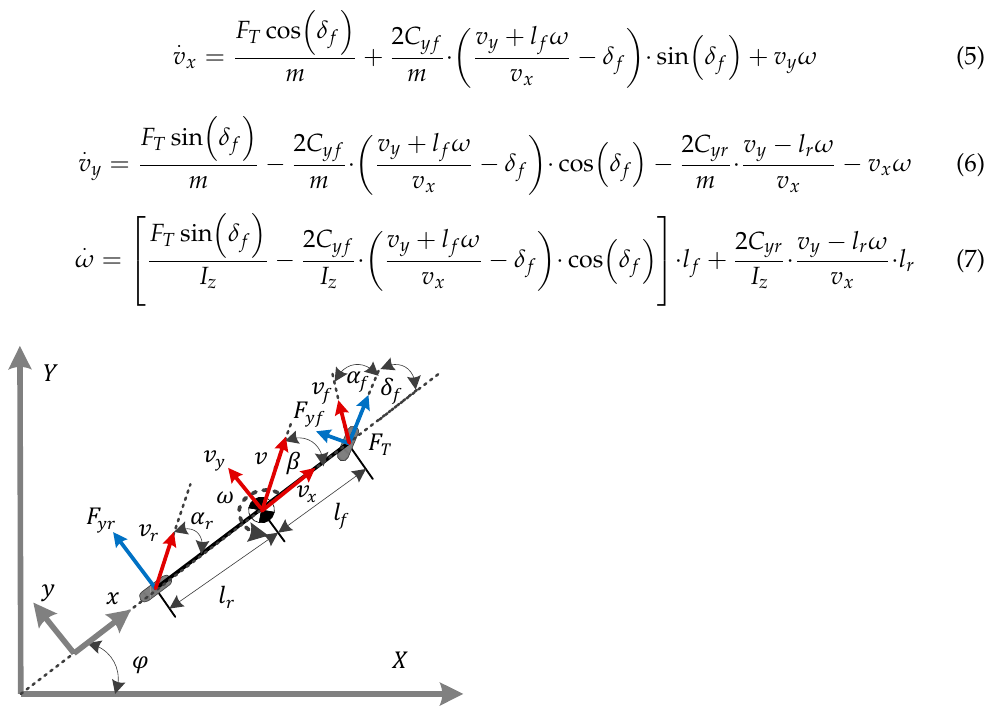
Figure 3. Vehicle dynamics model considering force coupling.